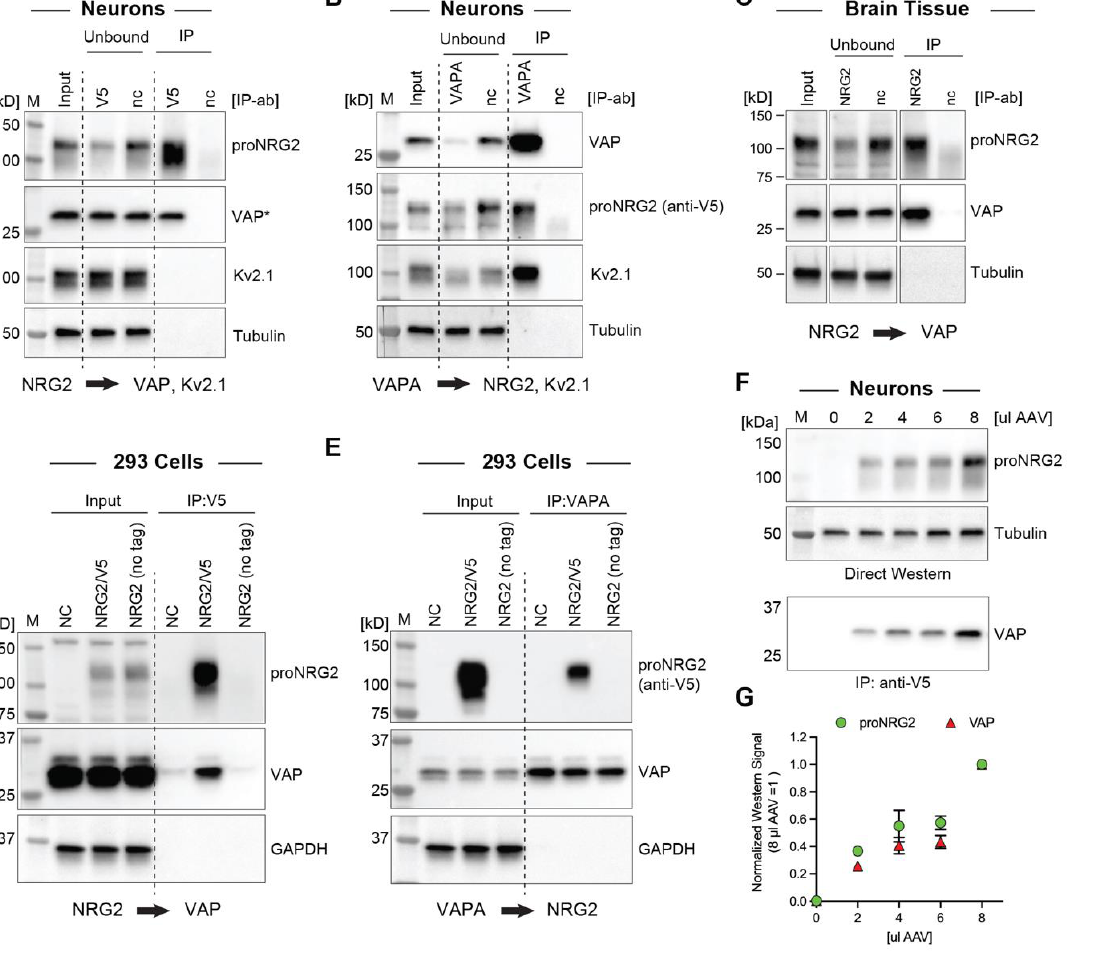
Figure 2. ProNRG2 and VAP co-immunoprecipitate in cultured neurons, brain tissue, and heterologous cells. ( A ), IP of epitope-tagged proNRG2 from transduced neuron lysates co-immunoprecipitates VAP detected with mouse monoclonal antibody clone N479/107 against VAPA/B [48], whereas VAP is not detected in the negative control IP lane ( nc ) using an isotype-matched negative control antibody (anti-GFP; clone N86/6). Importantly, unlike VAP, Kv2.1 is not detected in the V5-IP lane. The asterisk (*) indicates that input and unbound fractions were diluted fivefold for VAP detection. ( B ), Likewise, proNRG2 is detected along with Kv2.1 in parallel VAPA-IP samples prepared from the same neuron lysates. ( C ), VAP co-immunoprecipitates with proNRG2 from mouse whole brain lysates following IP with a rabbit polyclonal NRG2 antibody against the extracellular domain (ABN1654). nc , nega- tive control antibody (normal rabbit IgG). ( D , E ), ProNRG2 and VAP also co-immunoprecipitate